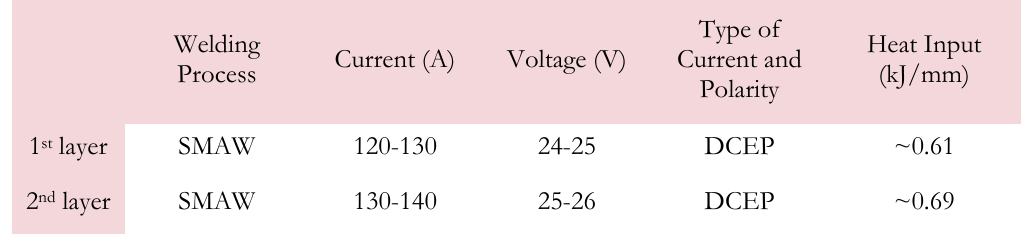
Table 3: Welding parameters of the cladding.